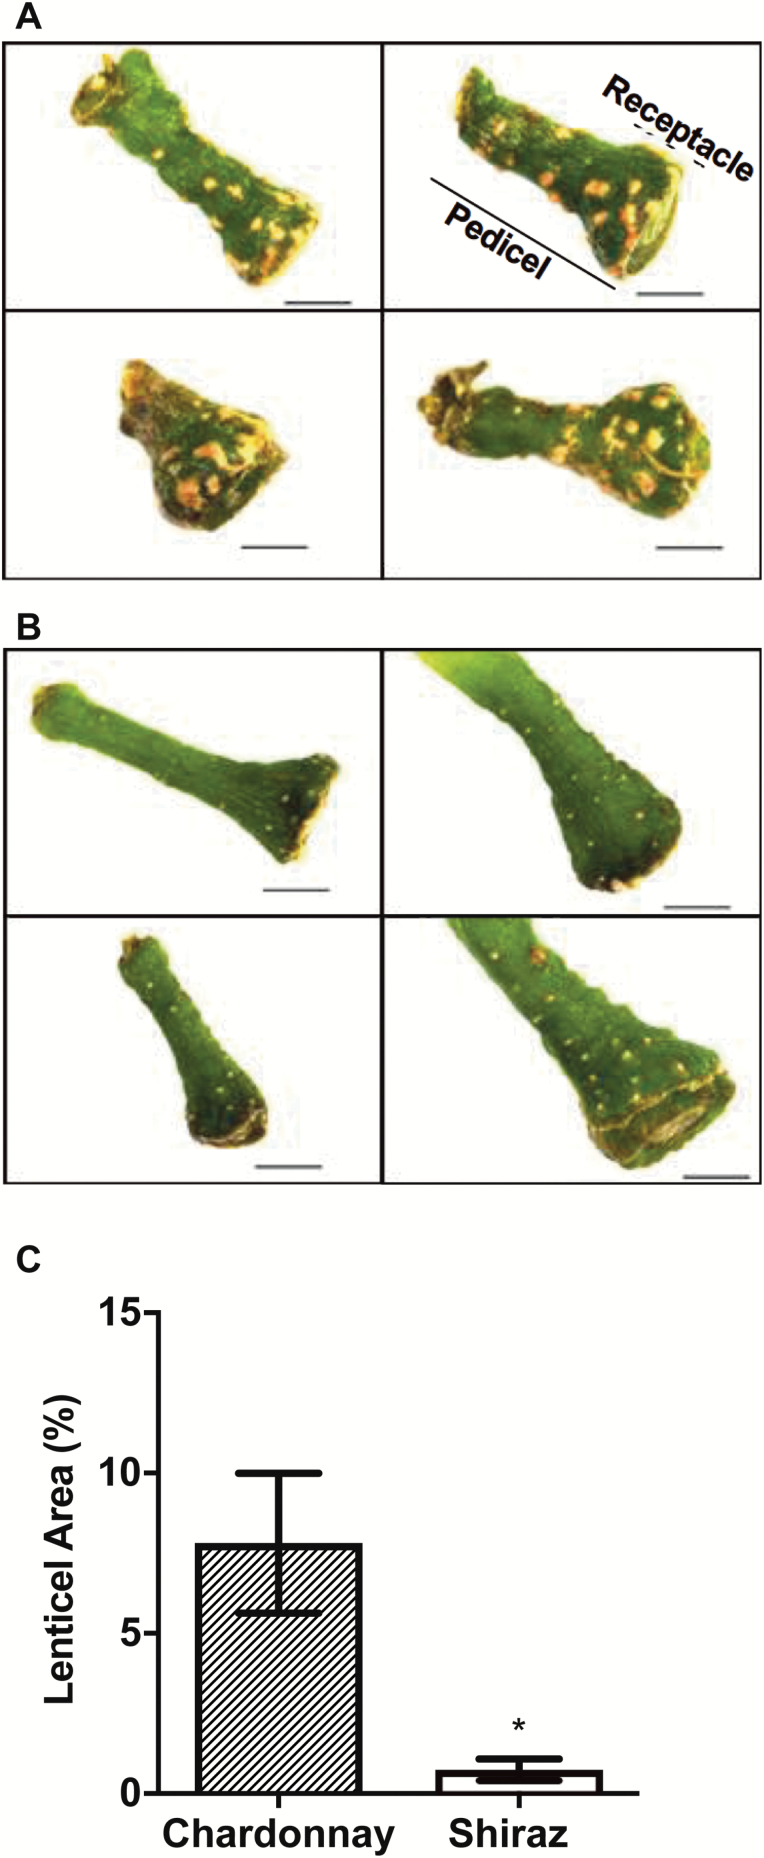
Differences in lenticel morphology and relative lenticel area between Chardonnay (A) and Shiraz (B) berry pedicels. (C) Lenticel area relative to pedicel surface area of Chardonnay and Shiraz berries (chamber grown, 2015) estimated using ImageJ. Scale bars in (A) and (B)=1 mm. Data in (C) are means ±SE, n=5, *Significantly different (t-test, P<0.05).